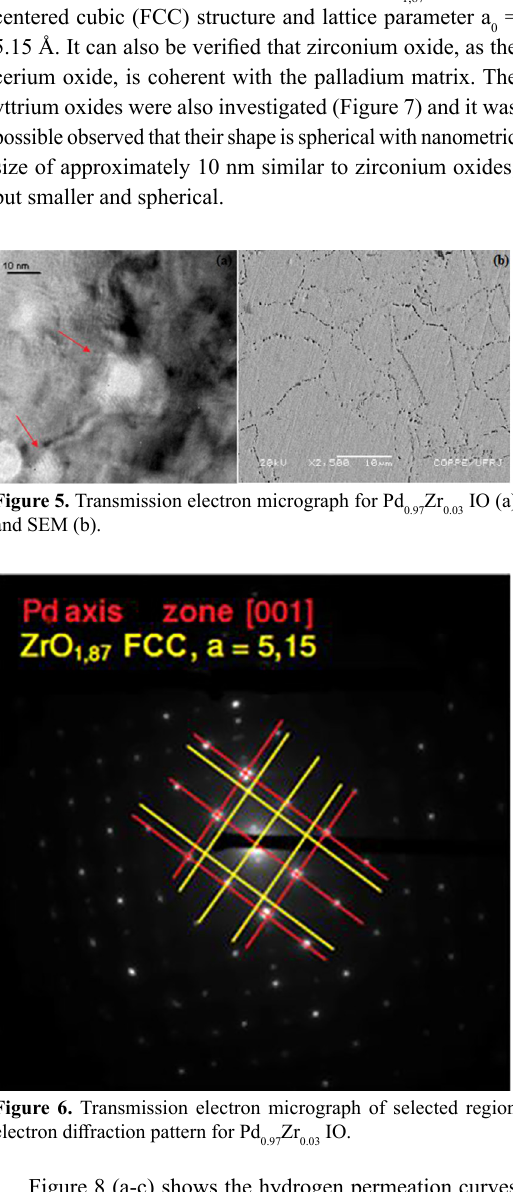
Y alloy: cold 0.97 0.03